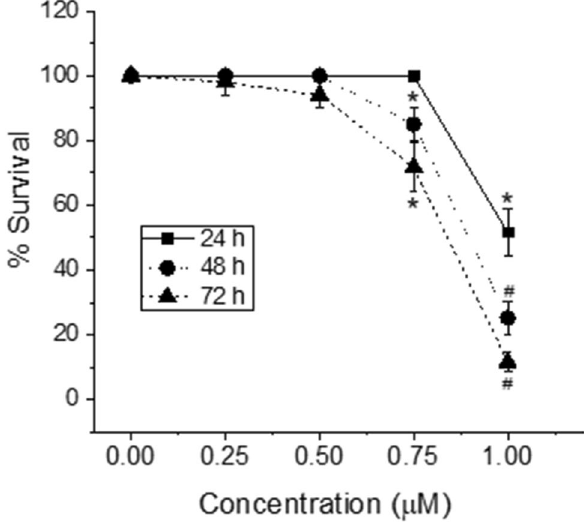
Figure 1. Concentration- and time-dependent toxicity of OTA in the zebrafish embryo model. Zebrafish embryos (72 hpf) were exposed to different concentrations of OTA (0, 0.25, 0.5, 0.75 and 1.0 µM). Percentage survival of the embryos were recorded after 24 h, 48 h and 72 h exposures. Concentration–dependent toxicity was observed, and increased with exposure time. Values shown are the mean ± standard deviation (n = 6 replicates per group, and 10 embryos per replicate). * P < 0.05 and # P < 0.01 as compared to untreated